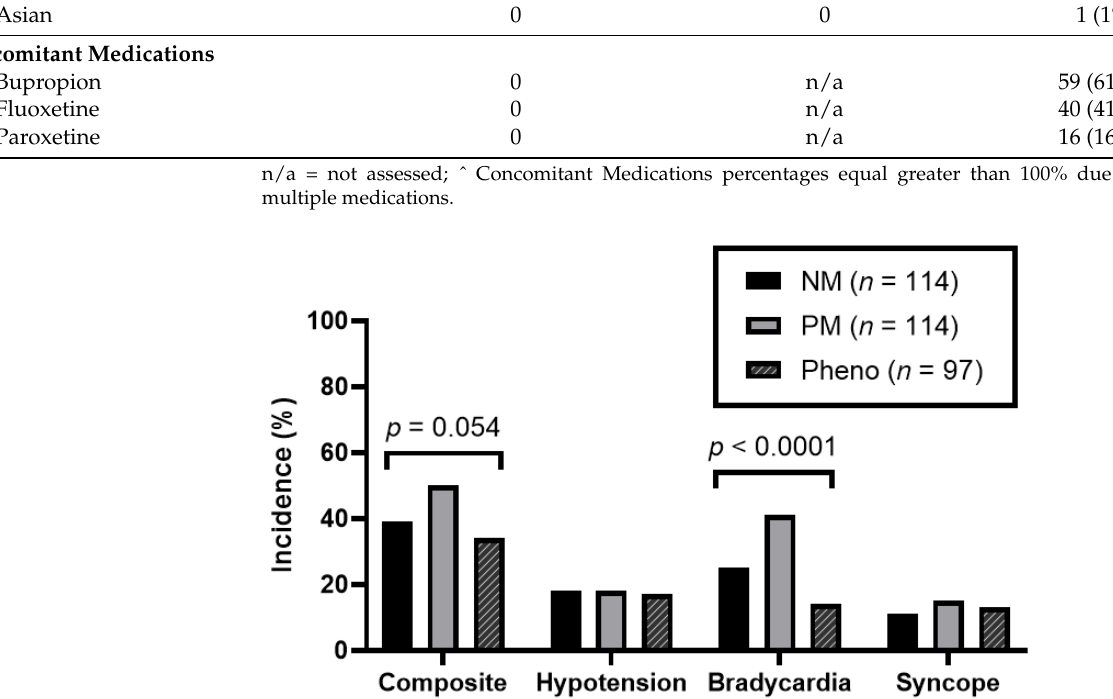
Figure 2. Incidence of primary composite outcome and individual components of the primary. Table 3. Incidence of primary and secondary outcomes stratified by CYP2D6 phenotype.